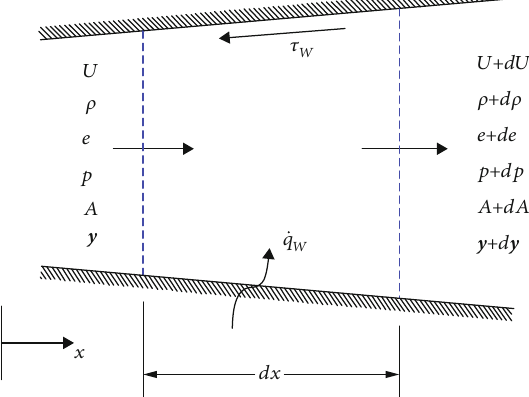
Figure 1: Control volume for compressible, unsteady fl